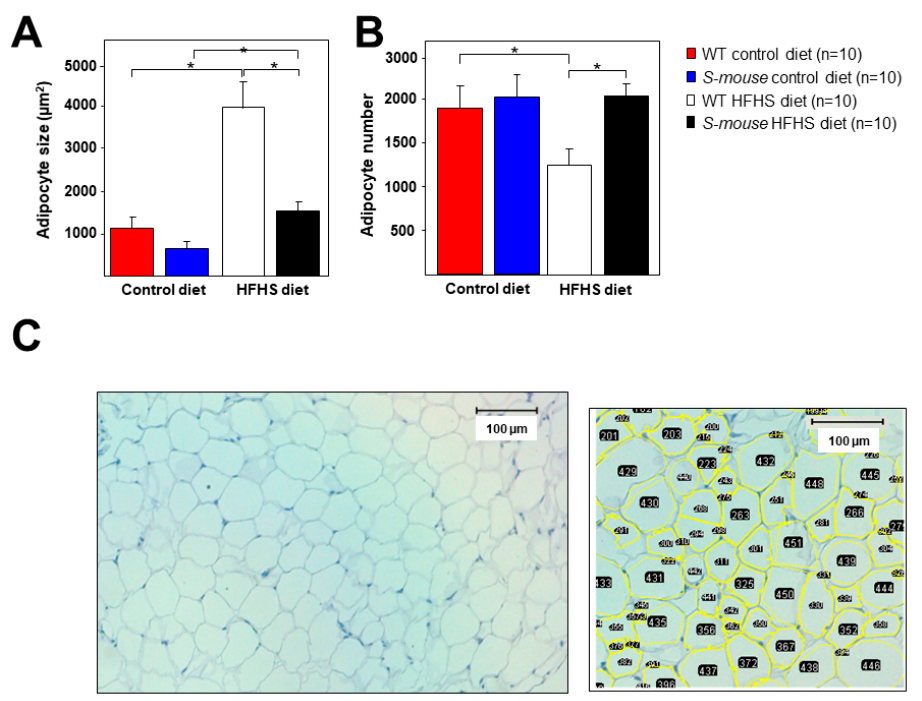
Figure 5. Adipose tissue characterization in WT and S-mice fed high-fat, high-sucrose or control diet for 16 weeks. ( A ) Quantification of adipocyte size and ( B ) adipocyte number in the adipose tissue for all groups of mice identified by hematoxylin-eosin staining. ( C ) Representative image quantified in A & B is shown. The ImageJ data acquisition detects the shape of the adipocyte and counts the number in the image. The same program shows the area of each adipocyte. Data are presented as mean ± SEM. Statistical analysis was performed using one-way ANOVA. * p ≤ 0.05. HFHS high-fat, high-sucrose. Nutrients 2020 , 12 , x FOR PEER REVIEW